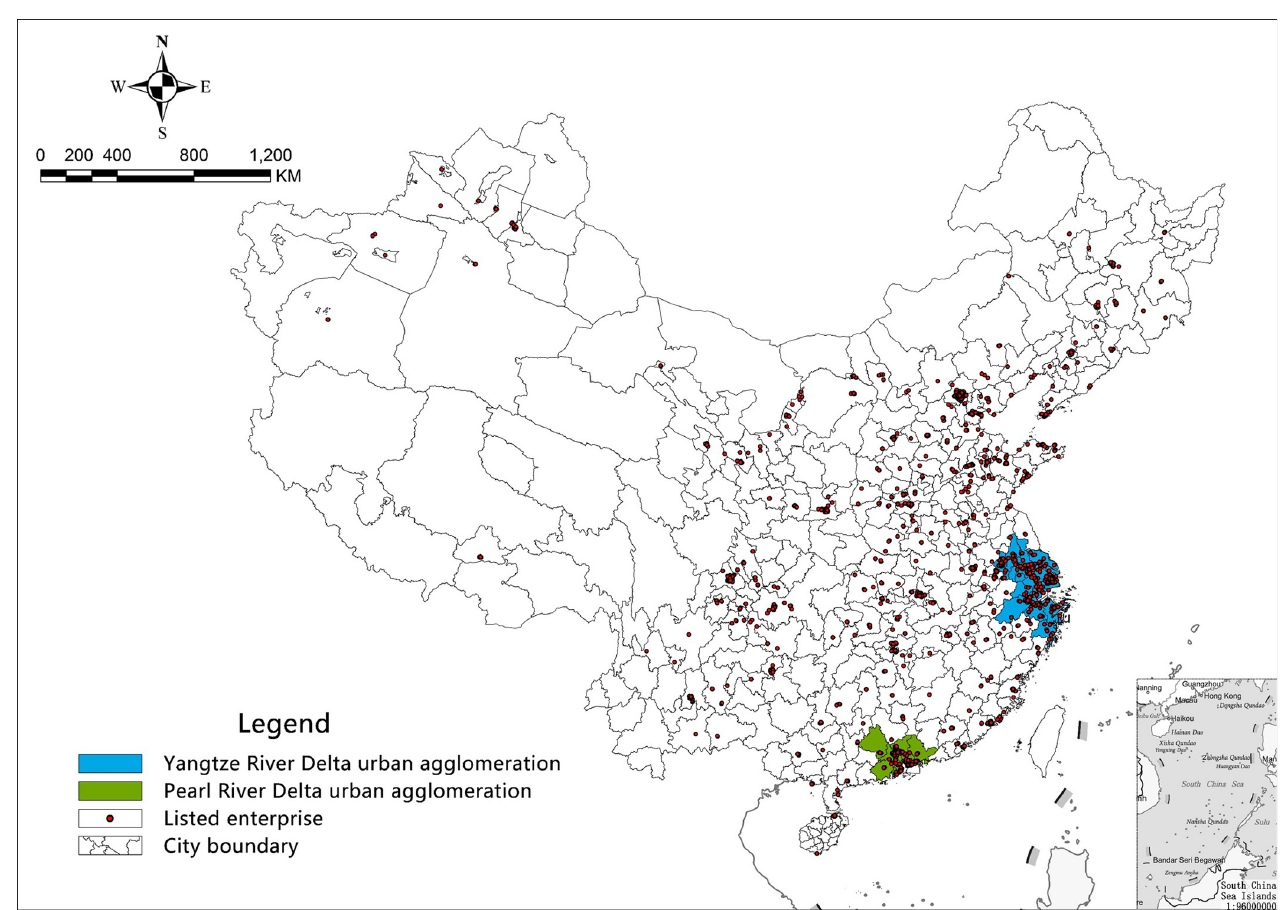
Fig 1. Urban agglomerations and listed enterprises.